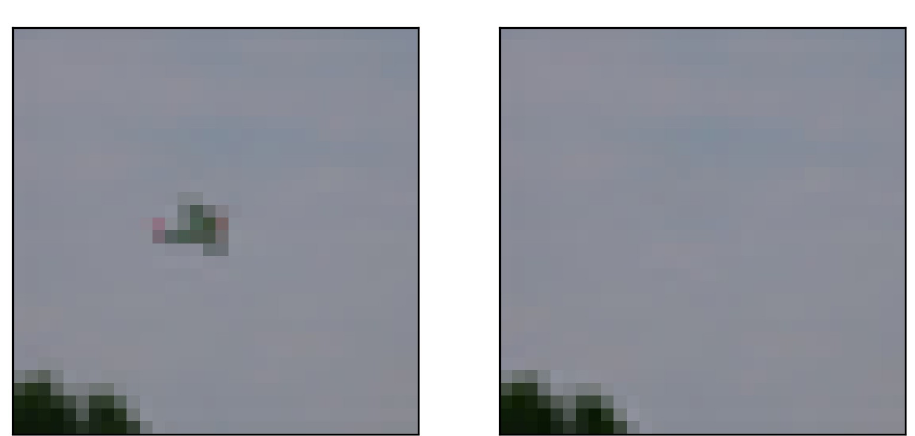
Fig 1. Example of false adversarial sample. We present an example of a false adversarial sample (right) and its respective original sample (left). The false adversarial sample is built with few total perturbations (i.e., low L 1 and L 2 ) but an unrecognisable final image (false adversarial sample). This results from the non-constrained spatial distribution of perturbations which is prevented if low L 0 or L 1 is used. This hypothetical attack has a L 2 of merely 356, well below the maximum L 2 for the One-Pixel ( L 0 � 1) Attack